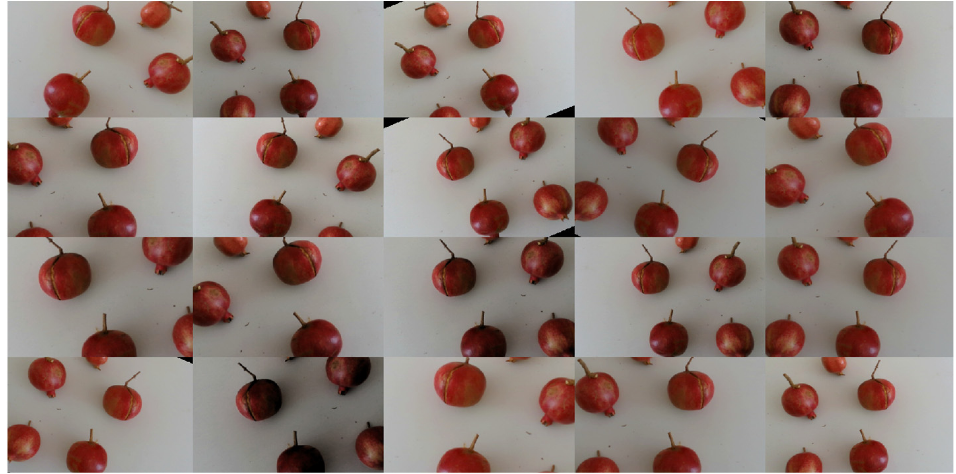
Figure 6. Data augmentation for the sample image of Figure 5. Twenty images are obtained by rotating, reflecting and varying contrast and exposure.